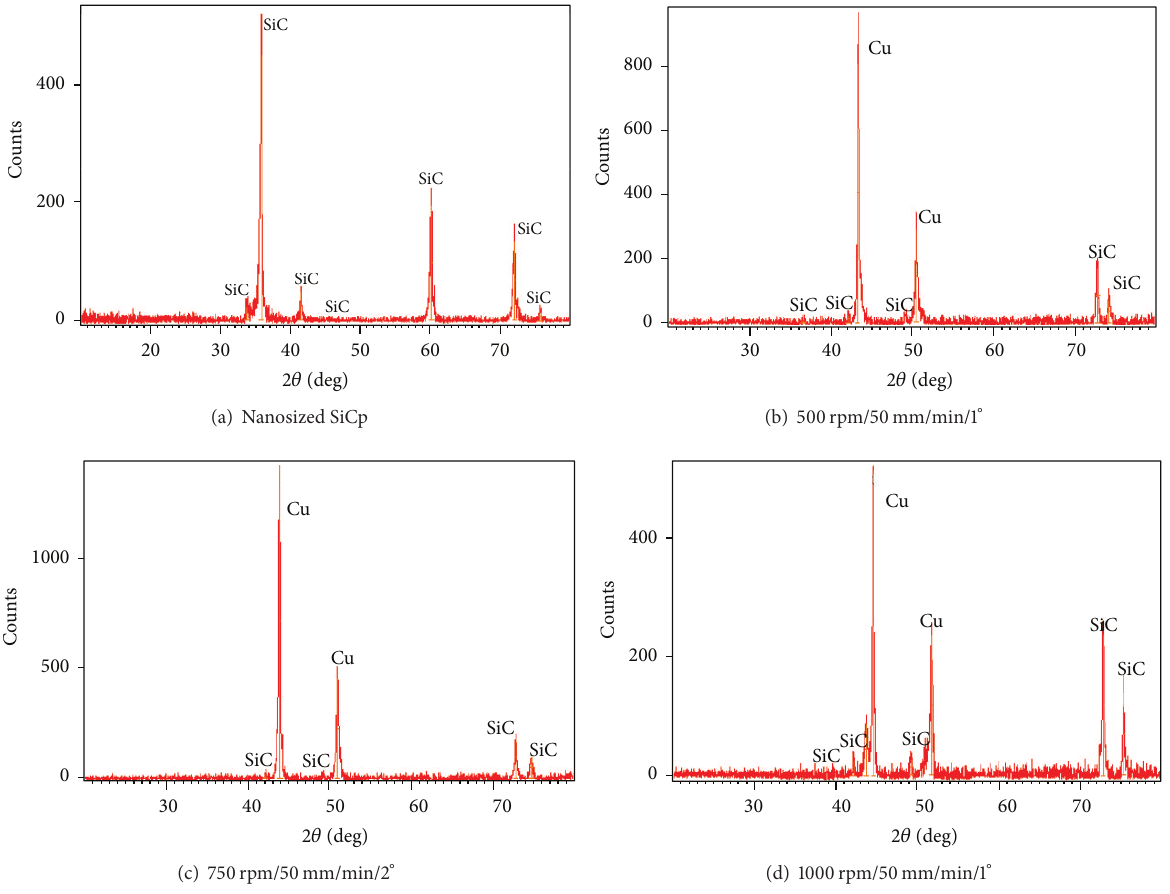
Figure 5: X-ray diffraction pattern of (a) nanosized SiCp and (b–d) nanocomposites at process parameter